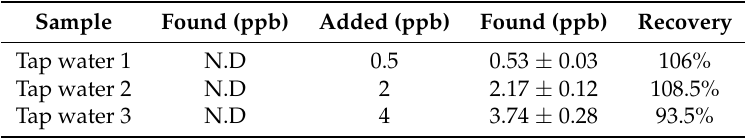
Table 1. Analytical result of Hg 2 + by the DPSV method in tap water.